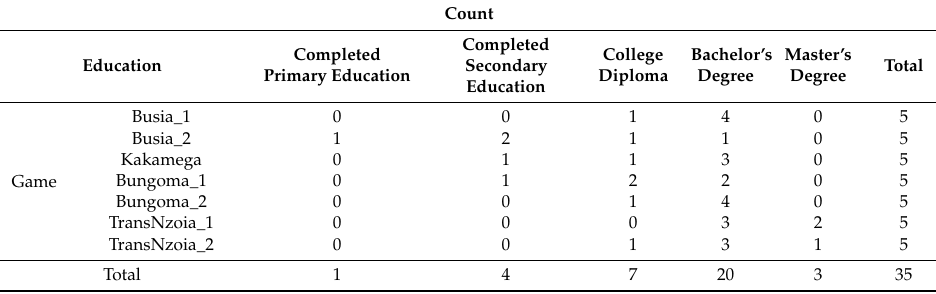
Table A8. Game * Education